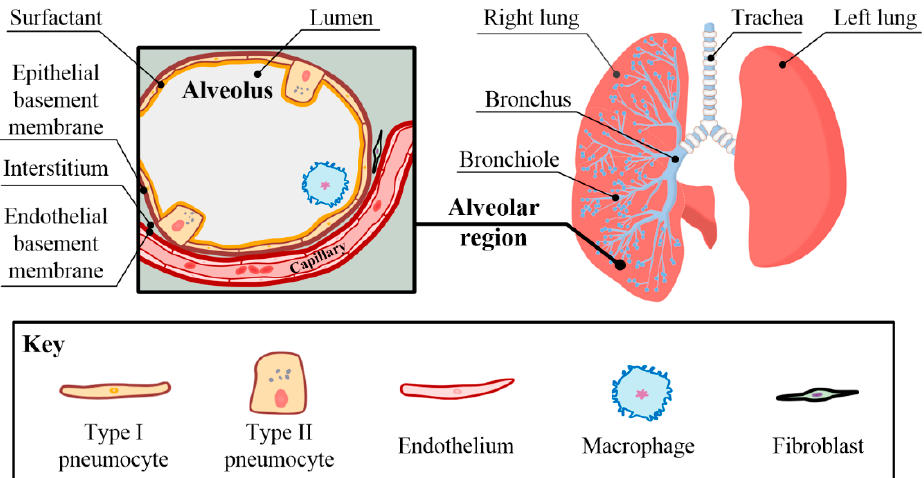
Figure 3. Schematic of mouse lower respiratory tract. The lower respiratory tract, along the proximal-distal axis, includes extrapulmonary airways, intrapulmonary airways, and alveolar regions. The alveolar regions are composed of several distinct layers, i.e., pneumocytes, epithelial basement membrane, interstitium, endothelial basement membrane, and endothelial cells. The pneumocytes are composed of type I pneumocytes responsible for air exchange and type II pneumocytes secreting surfactant proteins. A few macrophages may be present in the alveolar lumens or interstitium. Fibroblast can be found in the interstitium.